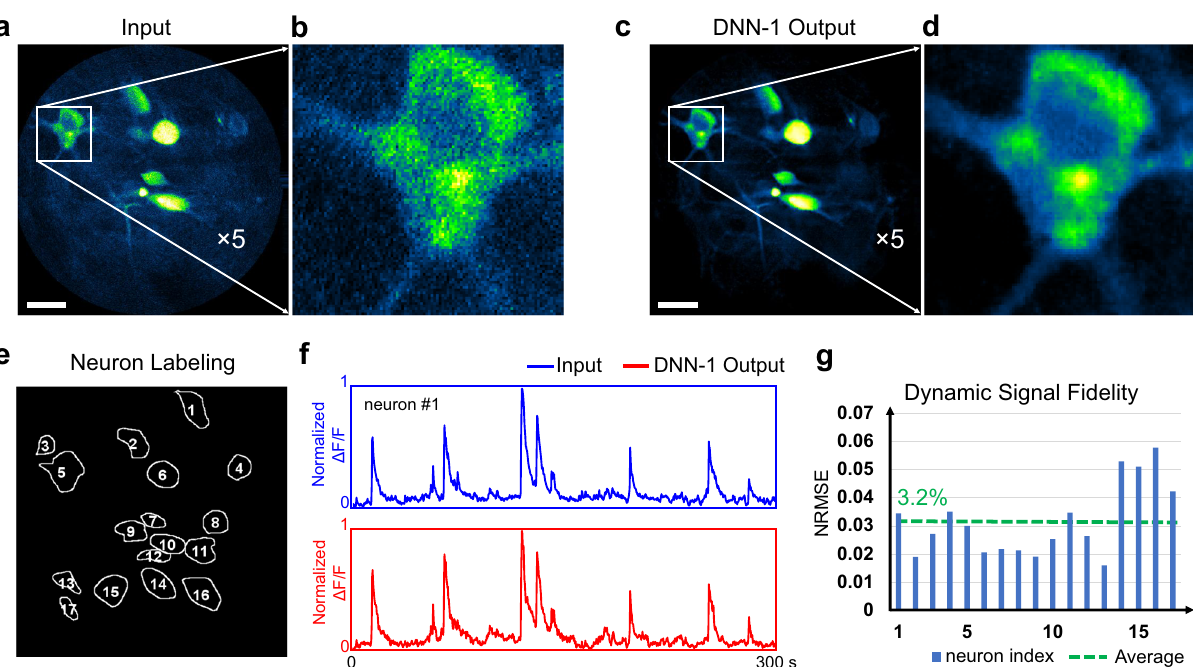
Fig. 2 Performance of DNN-1 for SNR enhancement of in vivo head- fi xed 2P fi berscopy images. a Representative input image along with the magni fi ed view ( b ) of the selected region. Images were acquired at a scanning speed of 3,360 spirals/sec and an imaging density of 512 spirals/frame. c Corresponding DNN-1 output image of ( a ) along with the magni fi ed view ( d ). e Neuron identi fi cation by using a post-processing pipeline. f Normalized time-dependent fl uorescence intensity ( Δ F / F ) of a selected neuron before and after DNN-1 enhancement. g Dynamic signal fi delity measured by normalized root-mean-square error (NRMSE) for each neuron. The differences of calcium signals between the DNN-1 output and the raw data are small (with an average discrepancy around 3%). Scale bars in ( a , c ): 20 µ